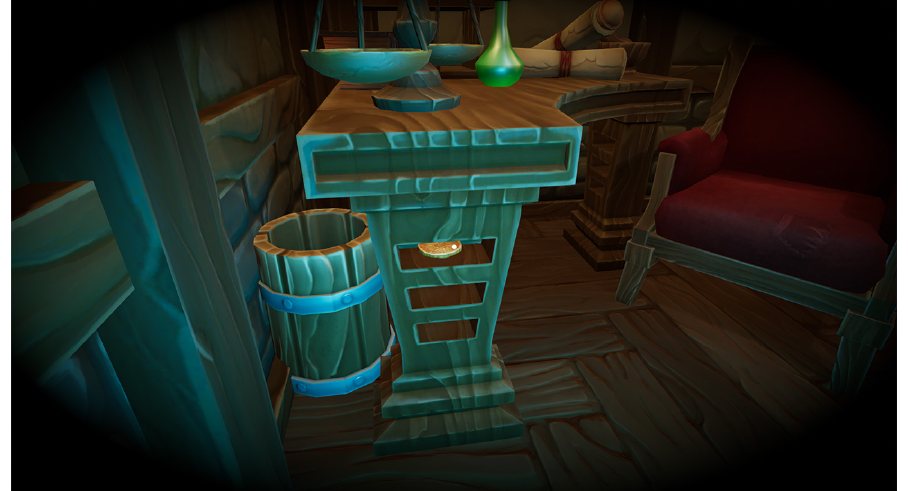
Figure 2. In the game prototype, the player takes the role of a thief, who has to steal as many coins as possible within a limited amount of